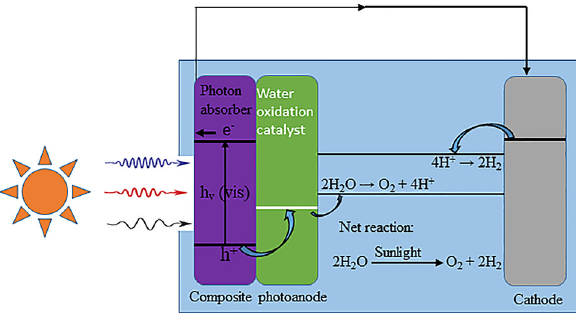
Figure 17: Schematic representation of photoelectrochemical water splitting adopted with permission from ref.